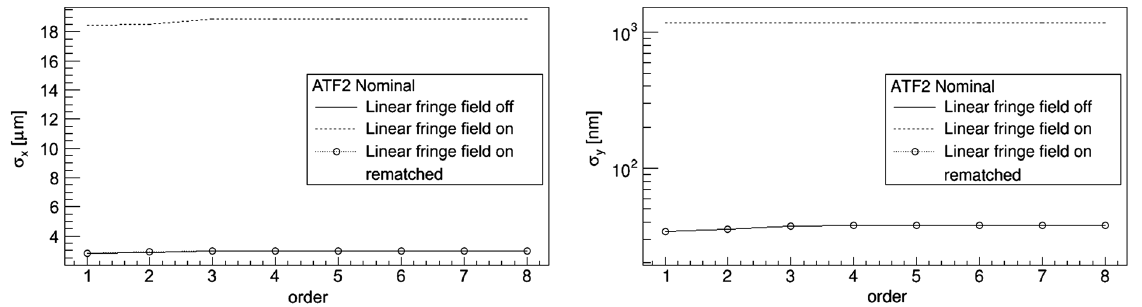
FIG. 4. Linear fringe field impact on the horizontal (left) and vertical (right) beam size in the ATF2 Nominal lattice, together with a correction of the fringe field effect using the FD quadrupoles as reported in Table III.